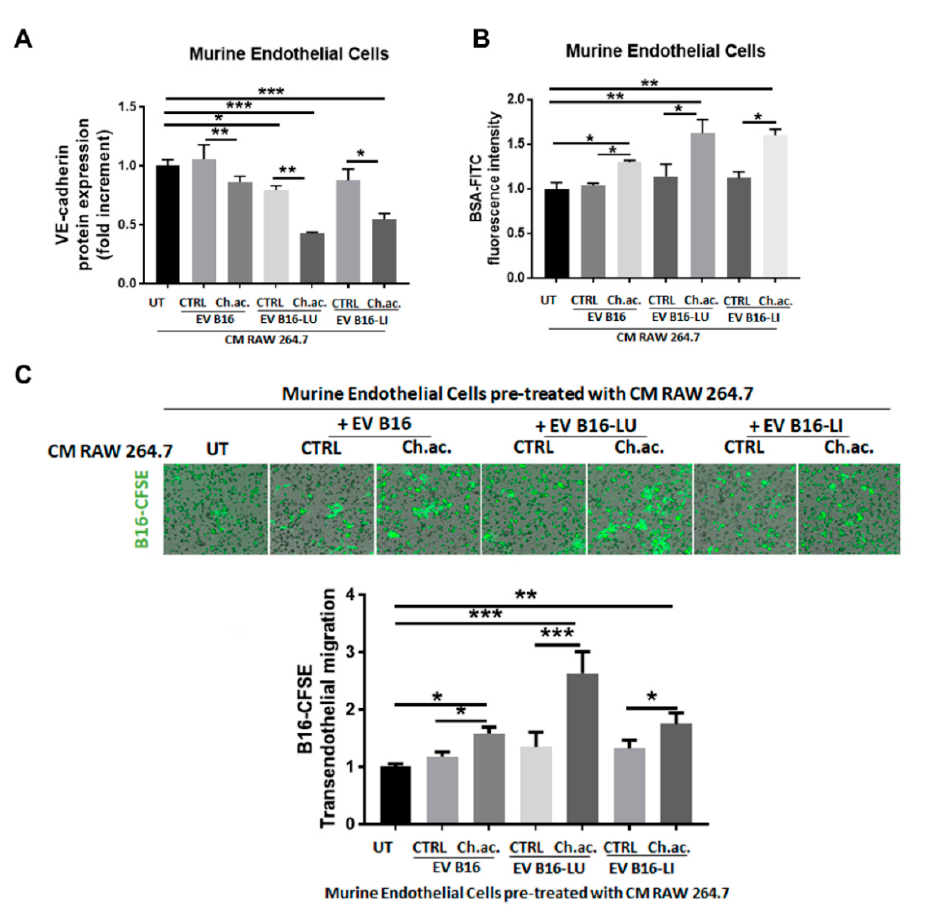
Figure 5. Vascular remodeling induced by the conditioned media of EV-treated macrophages. ( A ) Flow cytometric analysis of VE-cadherin protein expression in murine endothelial cells exposed to the CM of macrophages treated or not with melanoma-derived acid and control EV. ( B ) Perme- ability assay of murine endothelial cells exposed to the CM of macrophages treated or not with melanoma-derived acid and control EV. ( C ) Trans-endothelial migration of B16-CFSE melanoma cells through a monolayer of murine endothelial cells exposed to the CM of macrophages treated or not with melanoma-derived acid and control EV (one-way ANOVA; * p < 0.05, ** p < 0.01, and *** p <